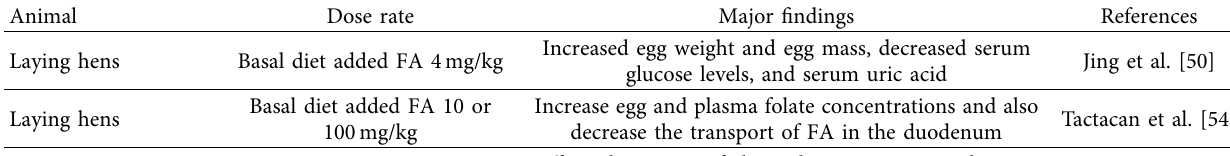
Table 2: Effect of folic acid in the